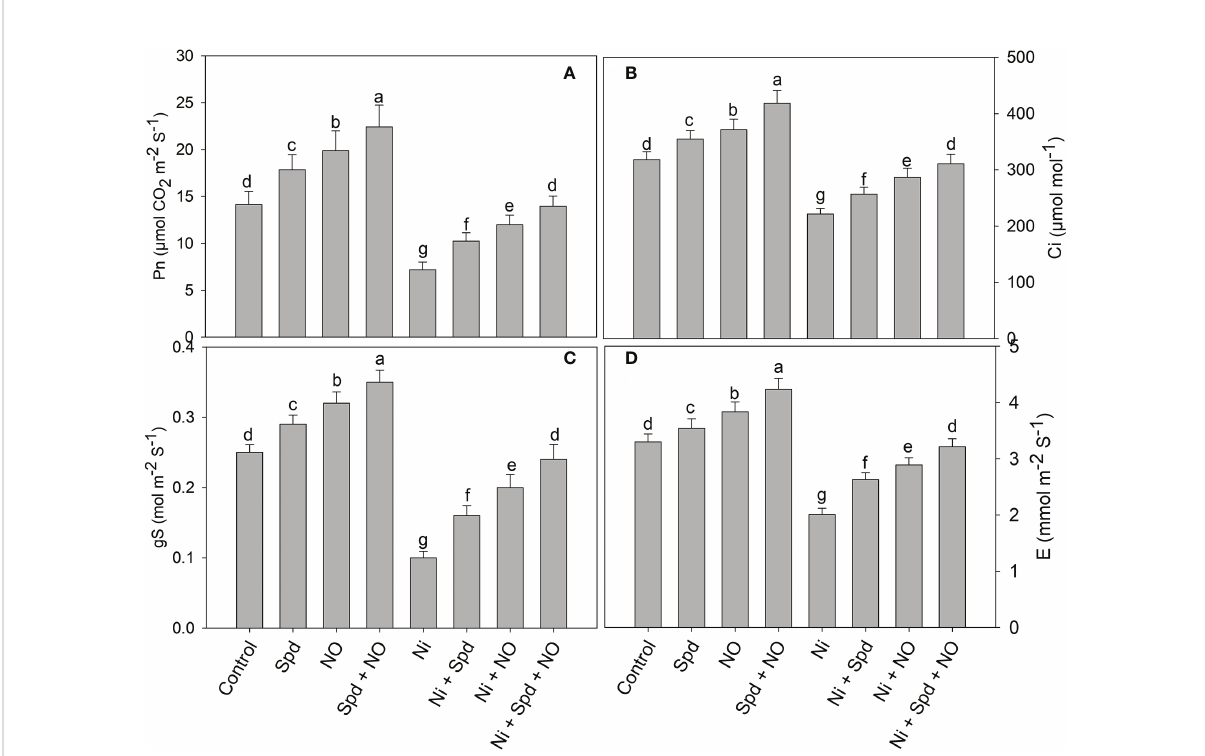
FIGURE 2 Effect of nitric oxide (50 µM) and spermidine (100 µM) supplementation on (A) photosynthesis, (B) intercellular CO2 concentration, (C) stomatal conductance and (D) transpiration rate in Solanum lycopersicum L. subjected to nickel stress. Data is mean (±SE) of four replicates and different letters on bars denote signi fi cant difference at P <